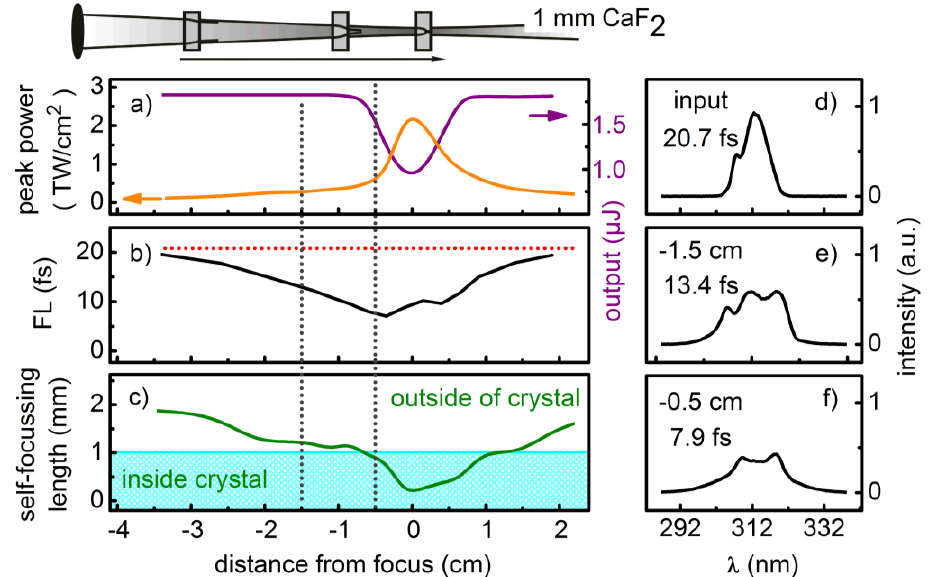
Figure 4. Correlation between the peak intensity and the measured output energy ( a ), output Fourier limit ( b ) and the calculated self-focal length ( c ) obtained by moving a 1 mm CaF crystal relative to the beam focus of a positively chirped pulse centered at 312 nm. 2 Measured spectra and calculated Fourier limits of the input pulse ( d ) and output pulses for selected crystal positions ( e , f